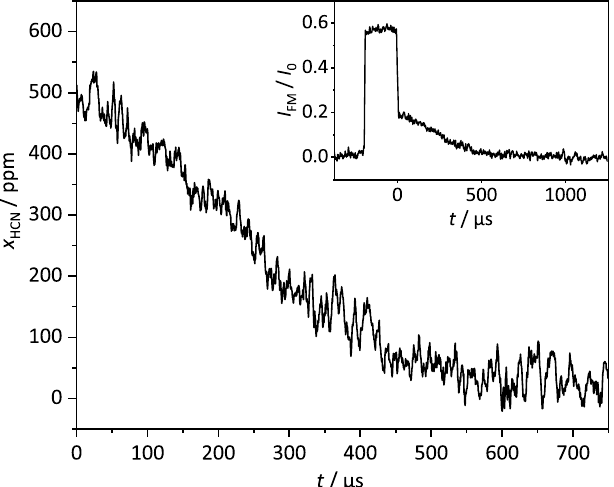
Figure 5. Kinetic profile of HCN during the reaction HCN + O behind the reflected shock wave (500 ppm HCN, 2.0% N 2 O, T = 1638 K, p = 1.24 bar, 2 MHz sampling rate, 10 points moving average). The inset shows the baseline-corrected and I 0 -normalized FM signal for pre-shock, incident wave, and reflected wave conditions. t = 0 marks the arrival of the reflected shock